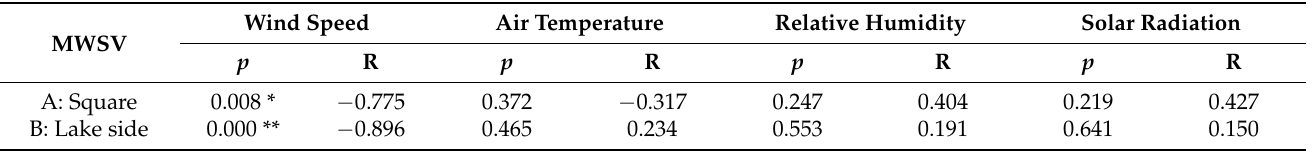
Table 5. Partial correlation significance and coefficients between TSV and different meteorological parameters in different seasons.